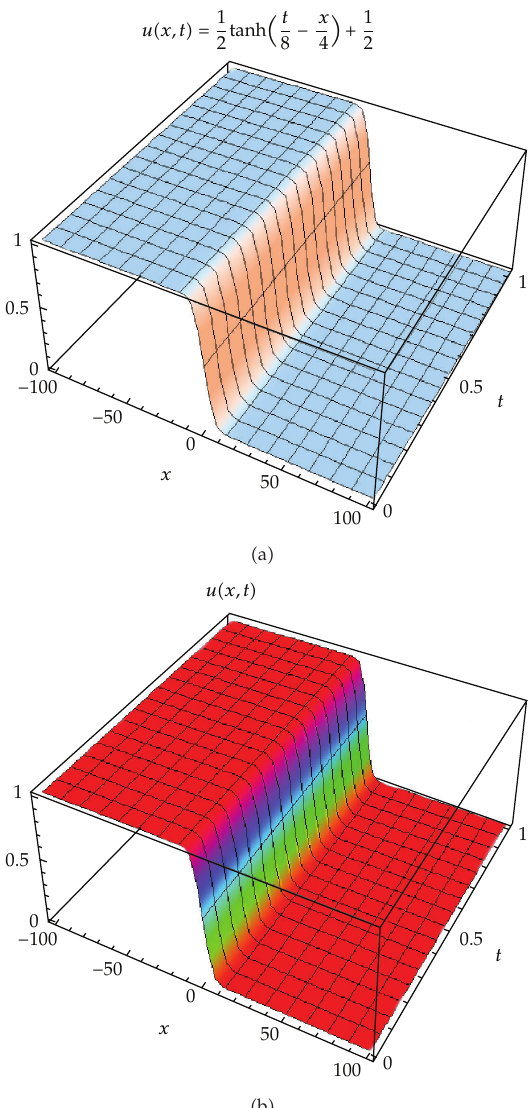
Figure 5: Comparison of the exact solution with the HAM solution of u (cid:2) x,t (cid:3) , when ħ (cid:8) − 0 . 5: (cid:2) a (cid:3) exact solution, (cid:2) b (cid:3) HAM